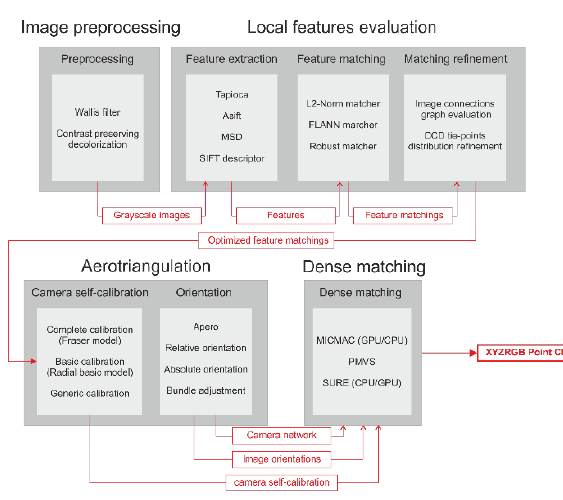
Figure 2. GRAPHOS workflow, from image pre-processing to dense point cloud